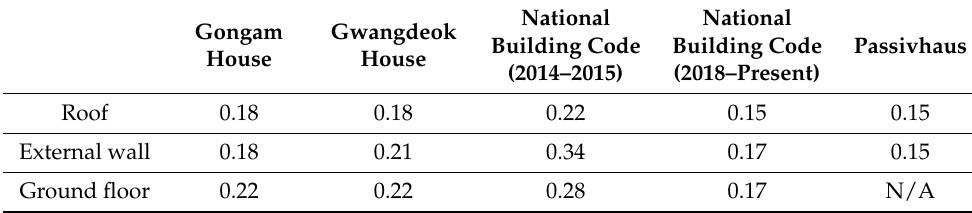
Table 1. Thermal performance of envelope. (Unit: W/m 2 K).